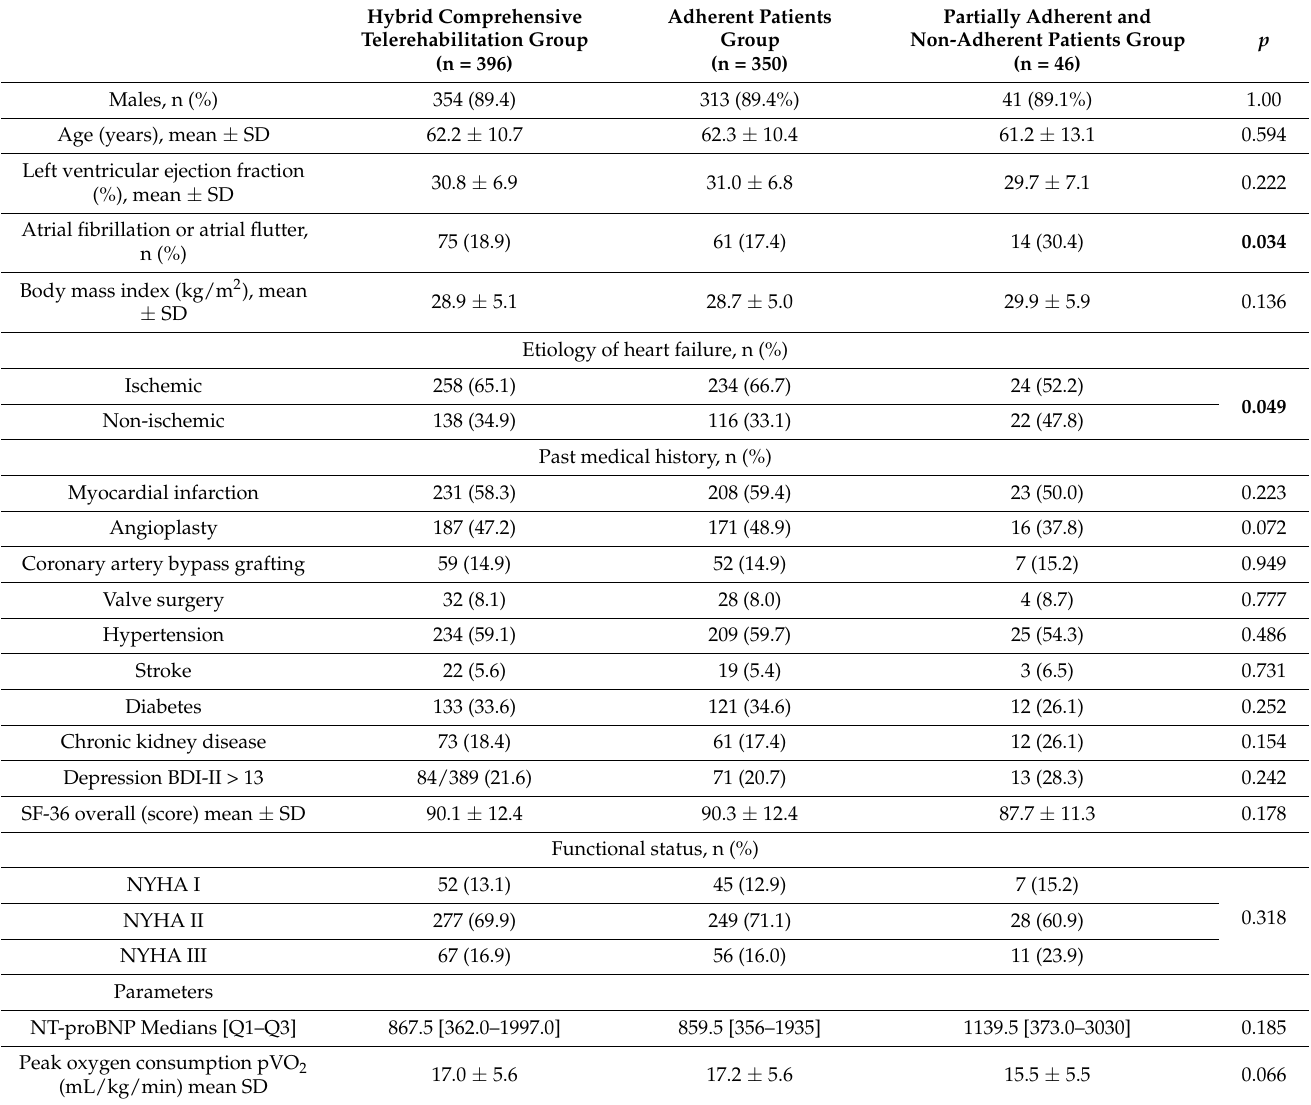
Table 1. Baseline characteristics of the hybrid comprehensive telerehabilitation group and comparison of baseline characteristics by degree of patients’ adherence to hybrid comprehensive